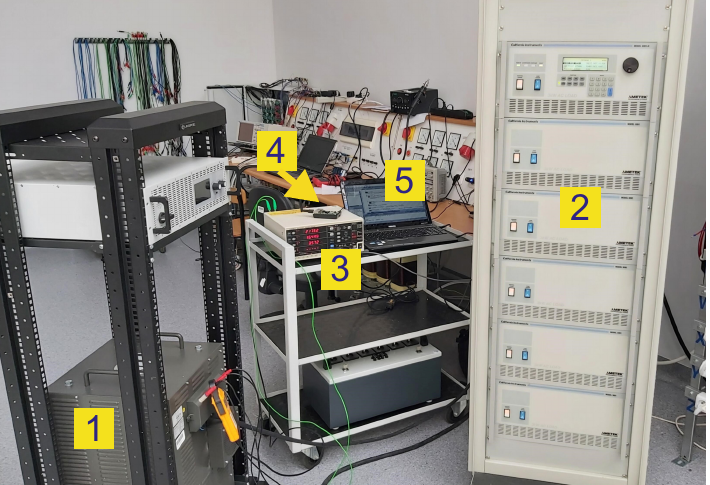
Figure 14. Photo of the laboratory experimental setup: 1—autotransformer, 2—programmable AC Load 3091LD, 3—power meter HIOKI PW3337, 4—Raspberry Pi 2, and 5—PC